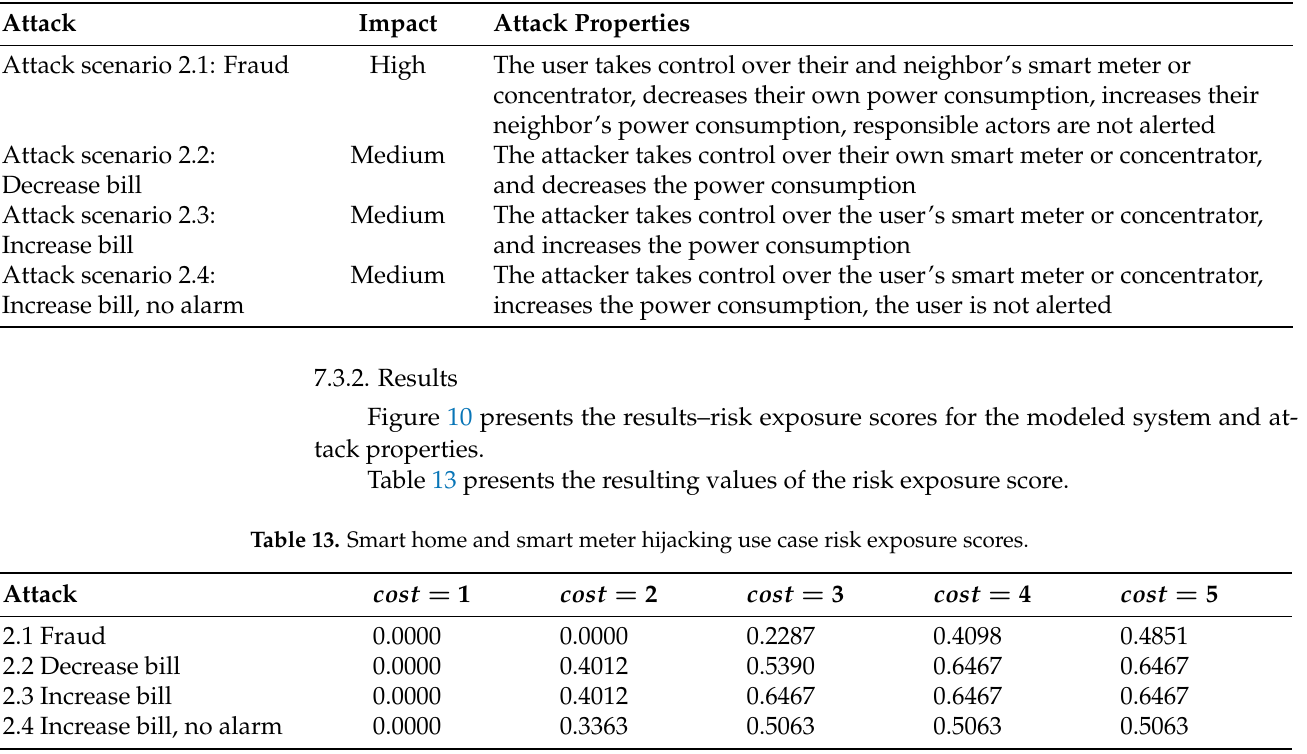
Table 12. Modeled attacks, their impact and properties for UC2.